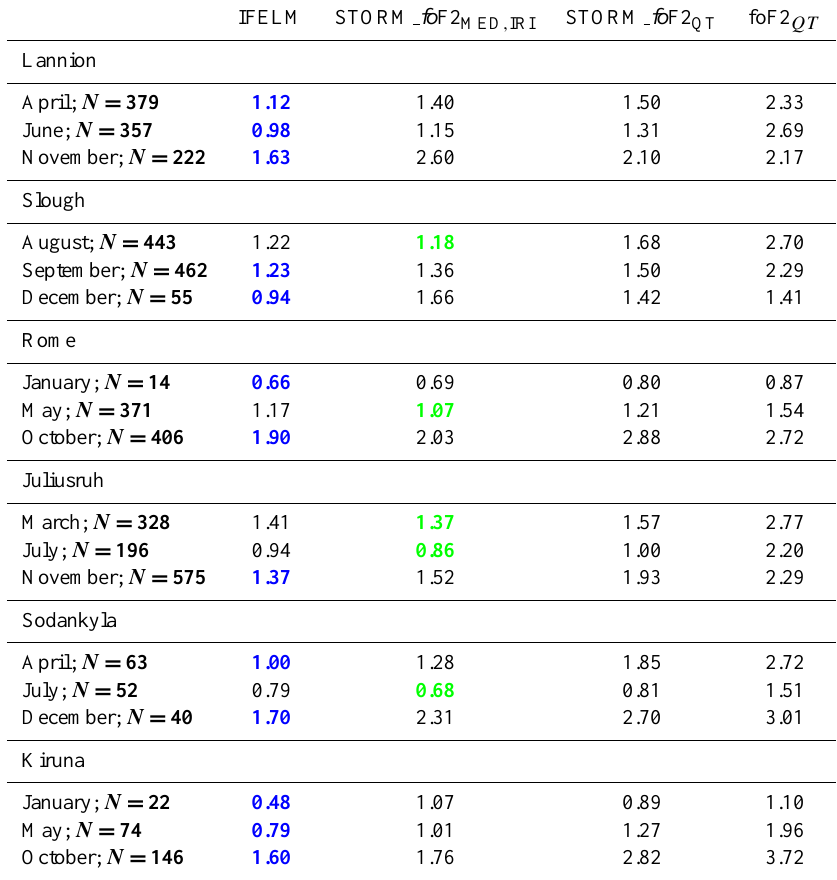
Table 2. Performance in terms of global r.m.s. error for very disturbed geomagnetic activity (ap( τ = 0 . 8/ τ = 0 . 9) > 32) for some stations located in the western (Lannion and Slough), central (Rome and Juliusruh), and eastern (Sodankyla and Kiruna) part of the area under consideration. The numbers in black bold indicate the number of samples considered for the calculation of the global r.m.s. error. The cases in which the IFELM, and STORM fo F2 MED , IRI , provide the best performance are reported in blue and green, respectively. IFELM STORM fo F2 MED , IRI STORM fo F2 QT foF2